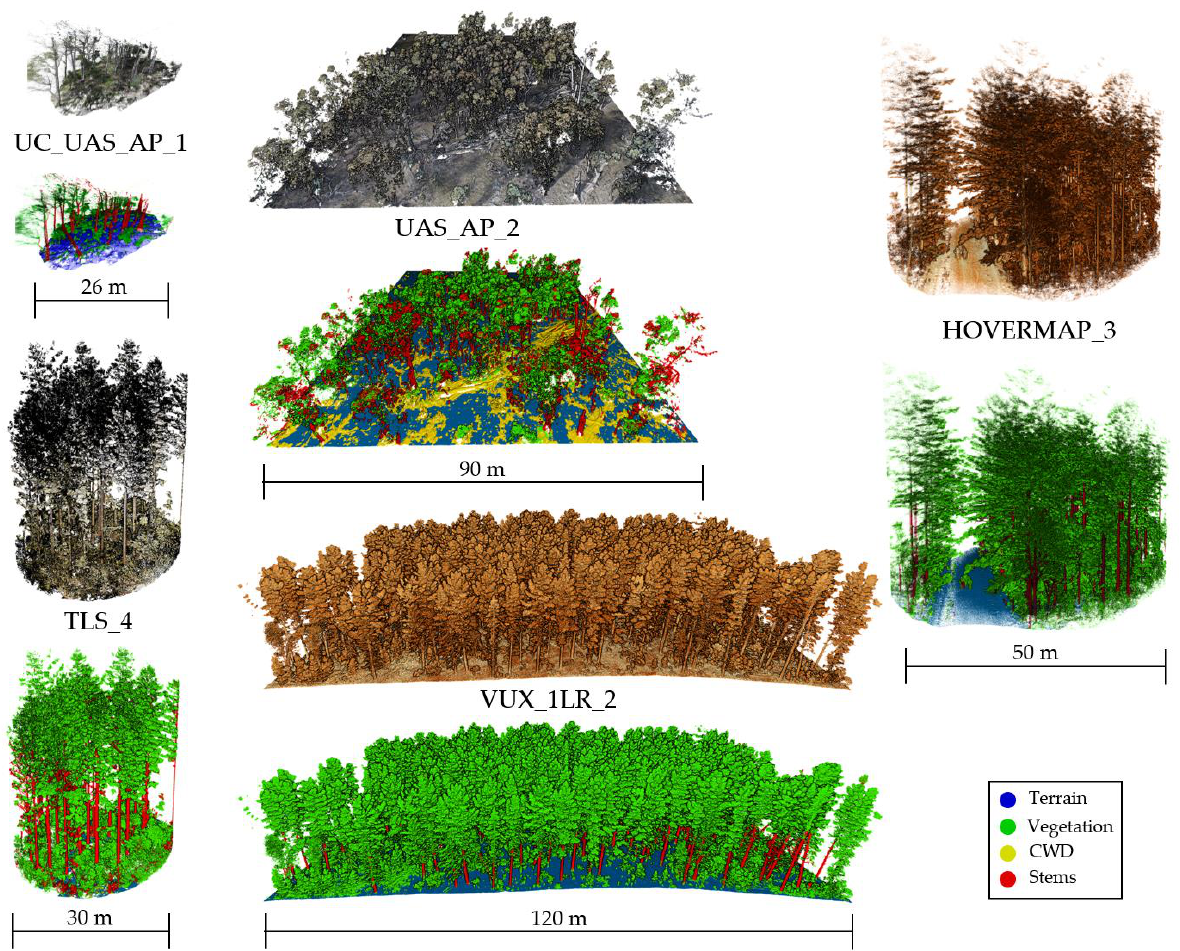
Figure 9. This figure presents five additional larger-scale point clouds from five different sensing techniques/sensors that were automatically segmented by the model. We provide a fly-through video of these datasets with the intent of transparently showing the strengths and weaknesses of the model (Krisanski, S. et. al, Sensor Agnostic Semantic Segmentation of Forest Point Clouds using Deep Learning (Part 2), https://www.youtube.com/watch?v=v0HwNu6SK6g, accessed on 30 March 2021).